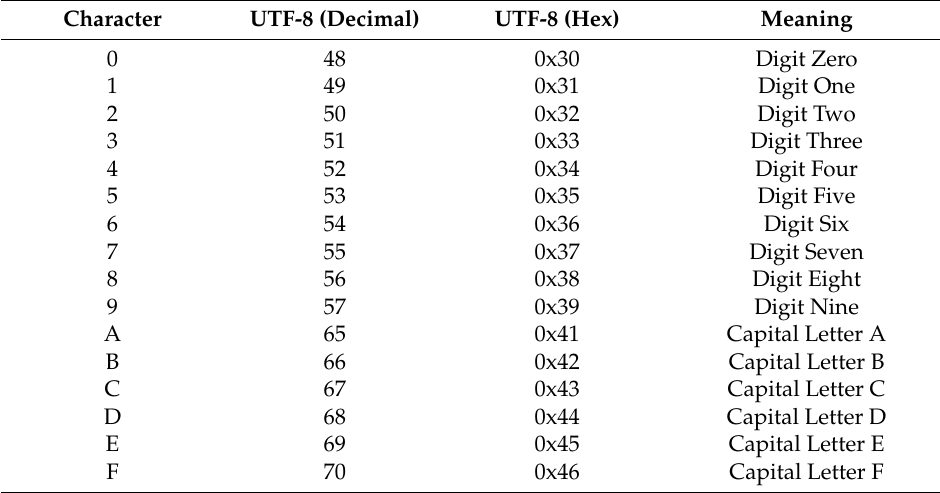
Table 3. UTF-8 encoding characters.